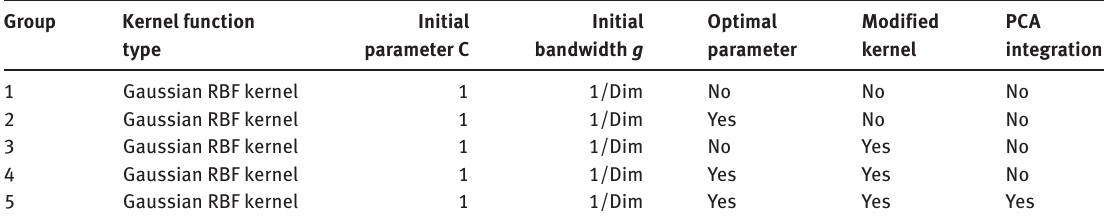
Table 2: The Experimental Group Parameter Settings.